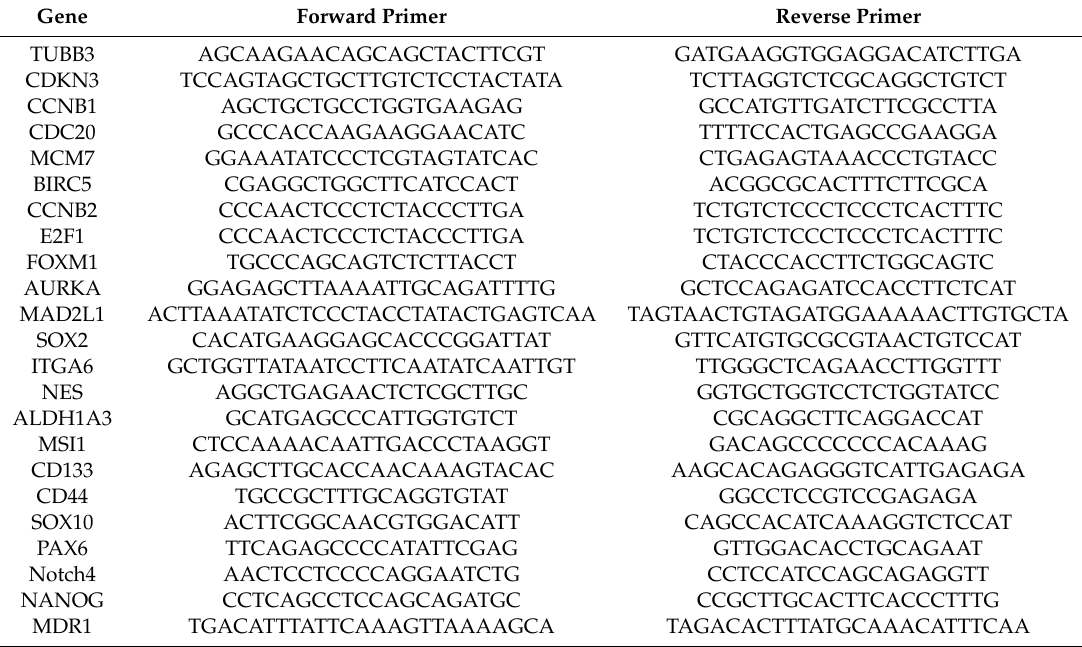
Table 1. Primer sequences for quantitative real